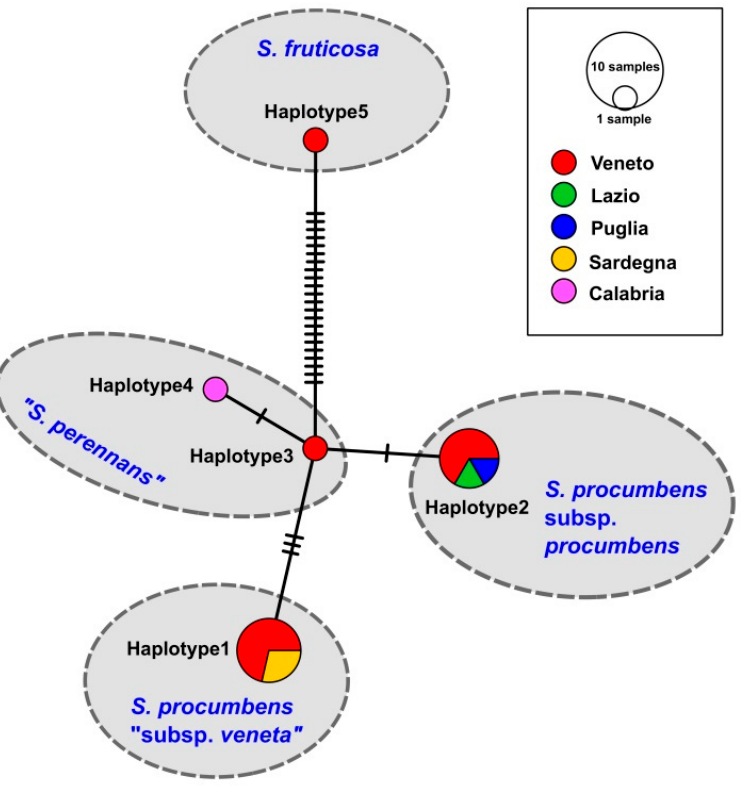
Figure 8. Minimum Spanning Network obtained with the program PopART of the plastid psb A -trn H haplotypes found in Italy for the genus Salicornia .